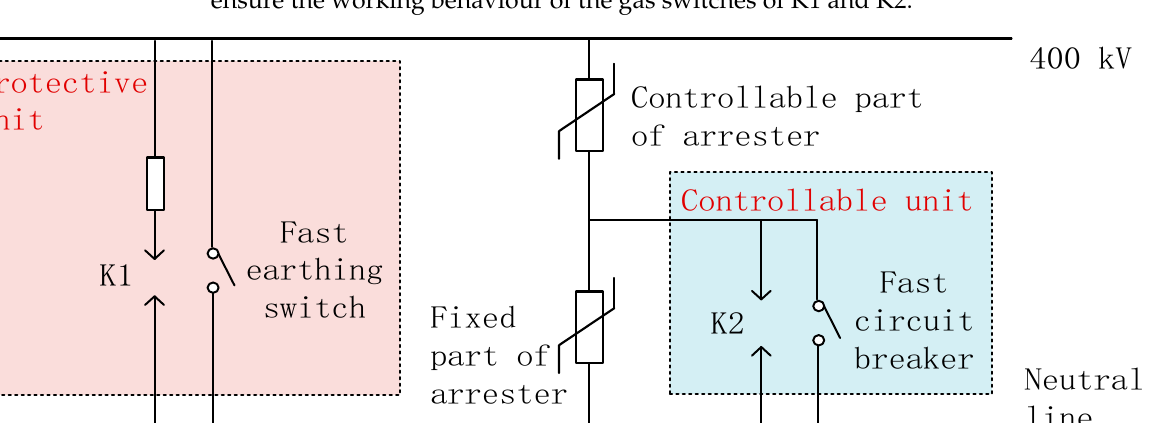
Figure 1. Schematic diagram of the controllable self-recovery dissipation device.